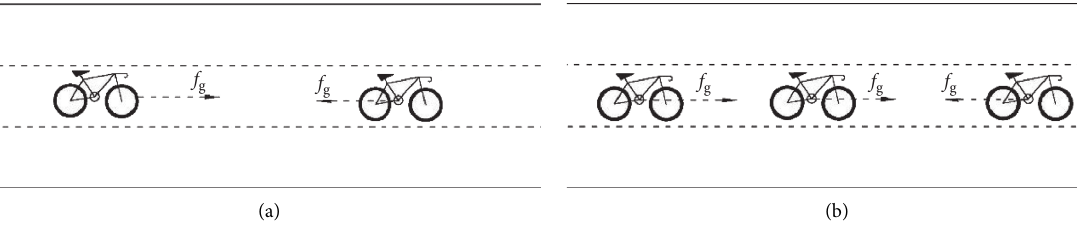
Figure 4: The schematic diagrams of following group force. The group sizes in (a) and (b) are, respectively, two and three. Table 1: The related parameters of the extended SF model. Parameters Values Parameters Values